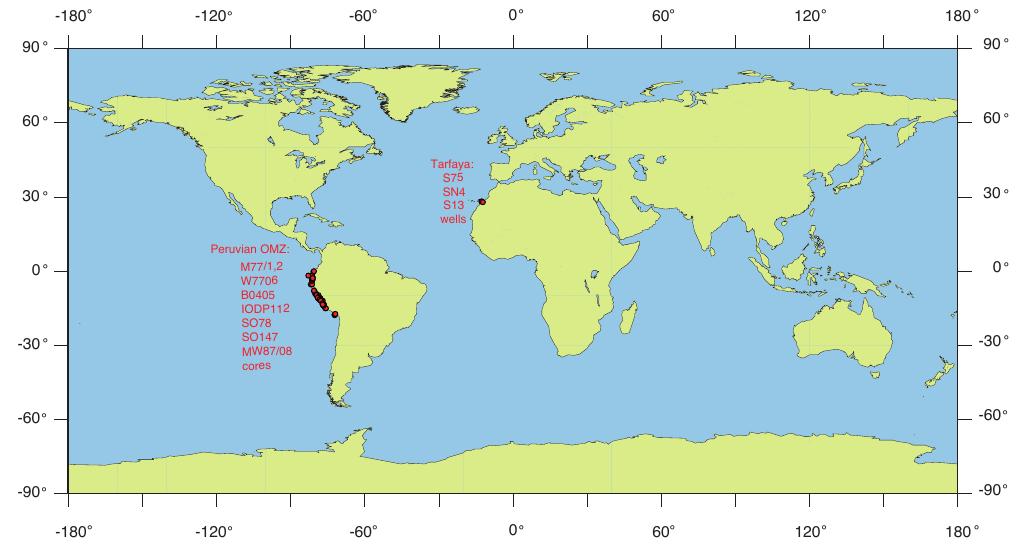
Figure 1. Location map of the sediment cores and wells studied.